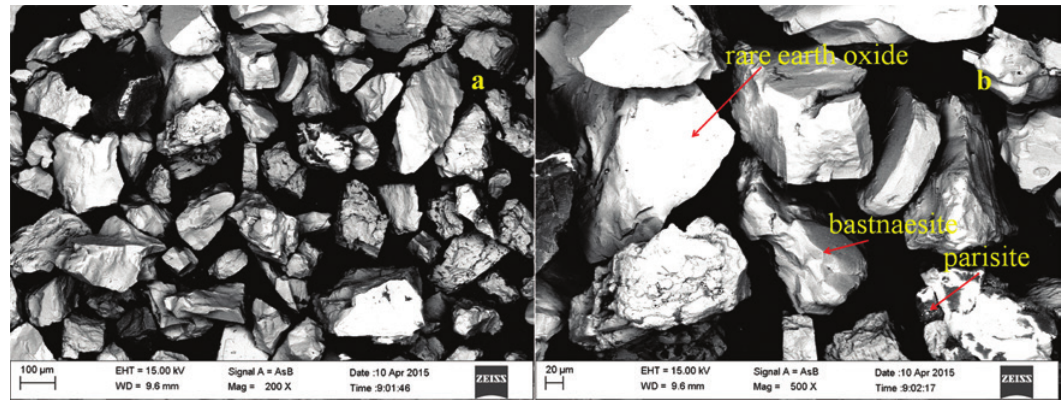
Figure 6: SEM image of bastnaesite concentrates.